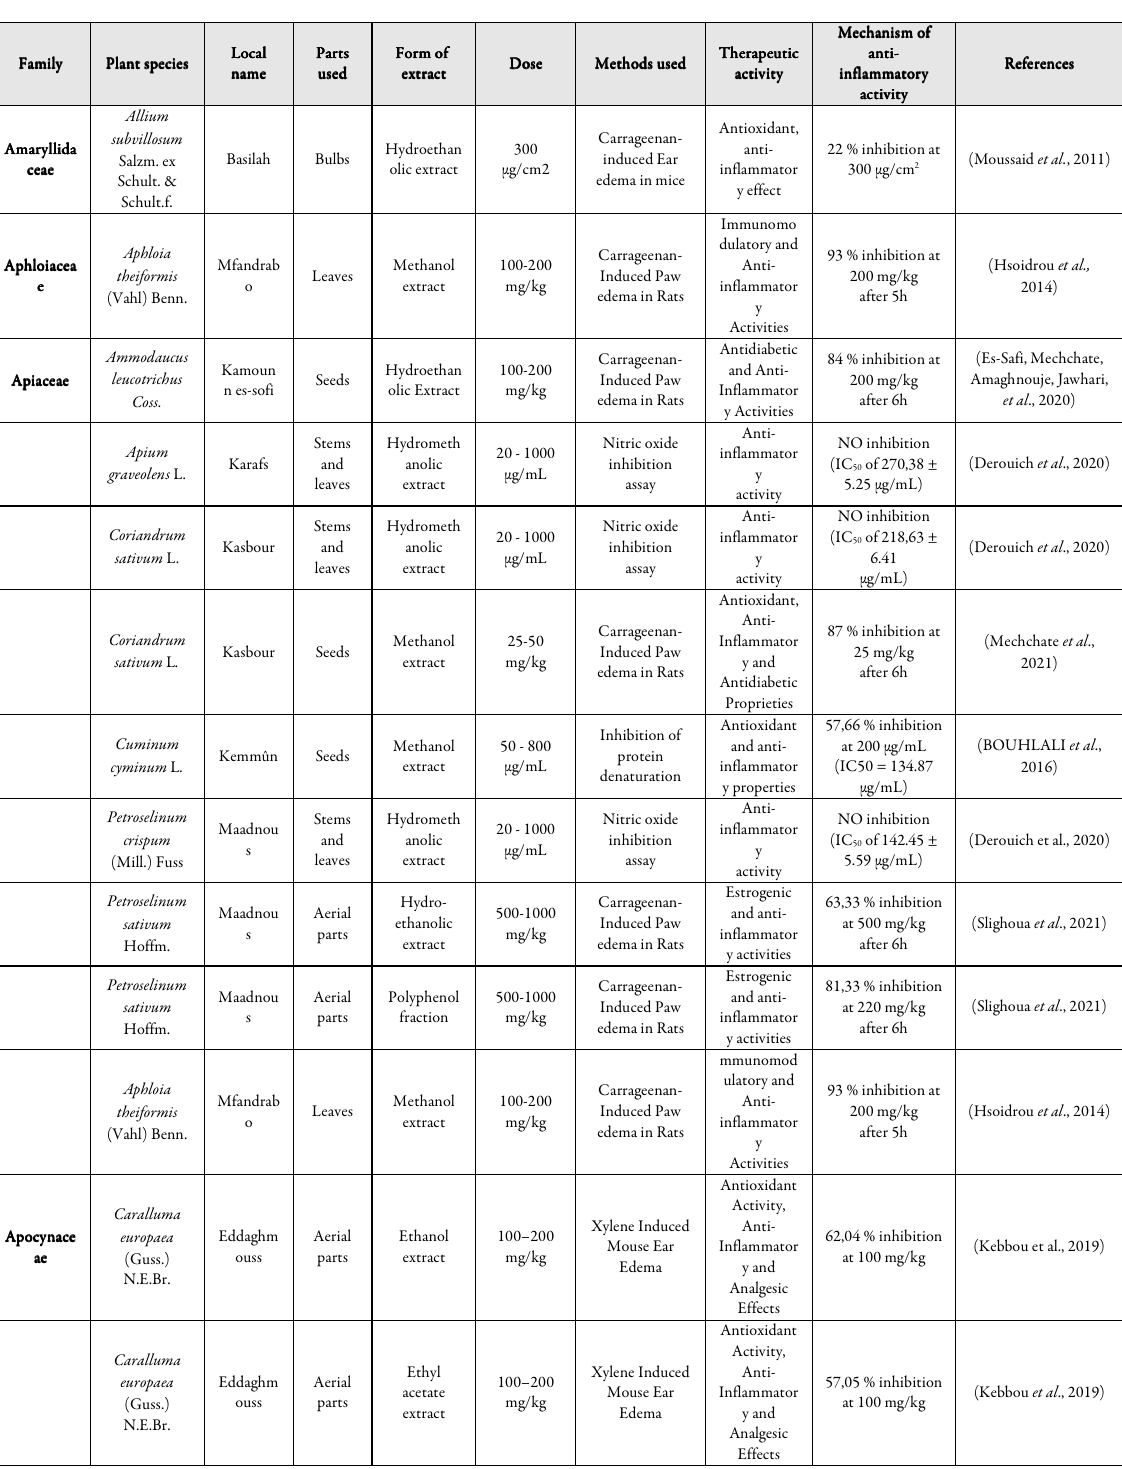
Table 2. Anti-inflammatory activities of Moroccan medicinal plants used traditionally to treat inflammation